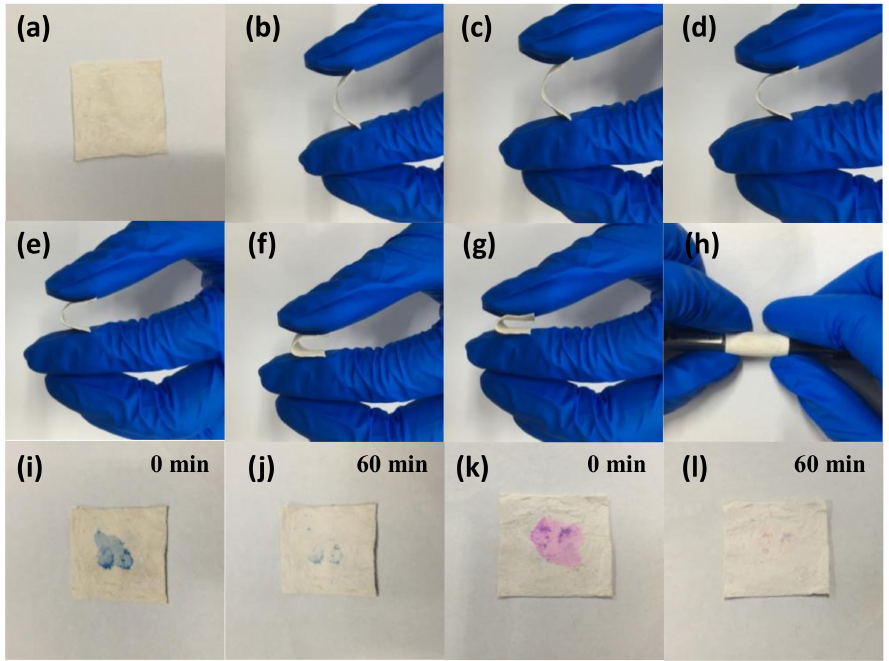
Figure 8. Photographs: flexible performance of TPCN2 ( a – h ), stained with MB ( i , j ) and RhB ( k , l ) under UV light irradiation,